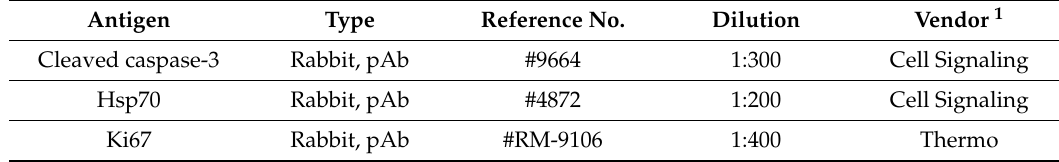
Table 1. Antibodies and conditions used for immunohistochemistry and immunofluorescence. Antigen Type Reference No. Dilution Vendor 1 Cleaved